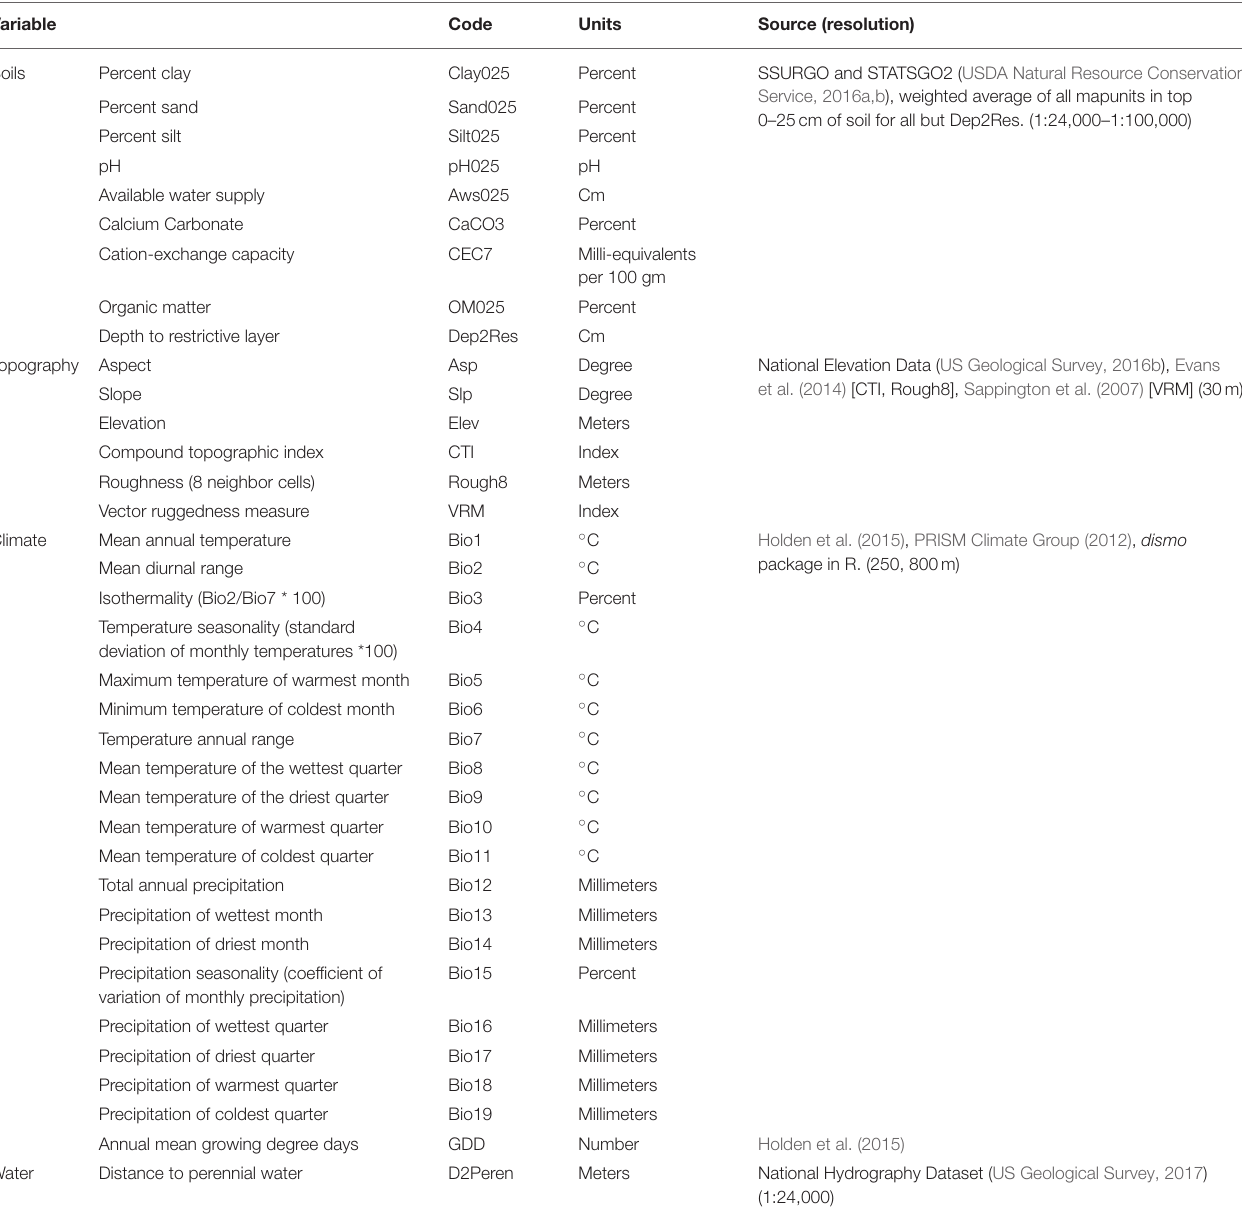
TABLE 1 | Environmental variables used in monarch and milkweed distribution modeling in